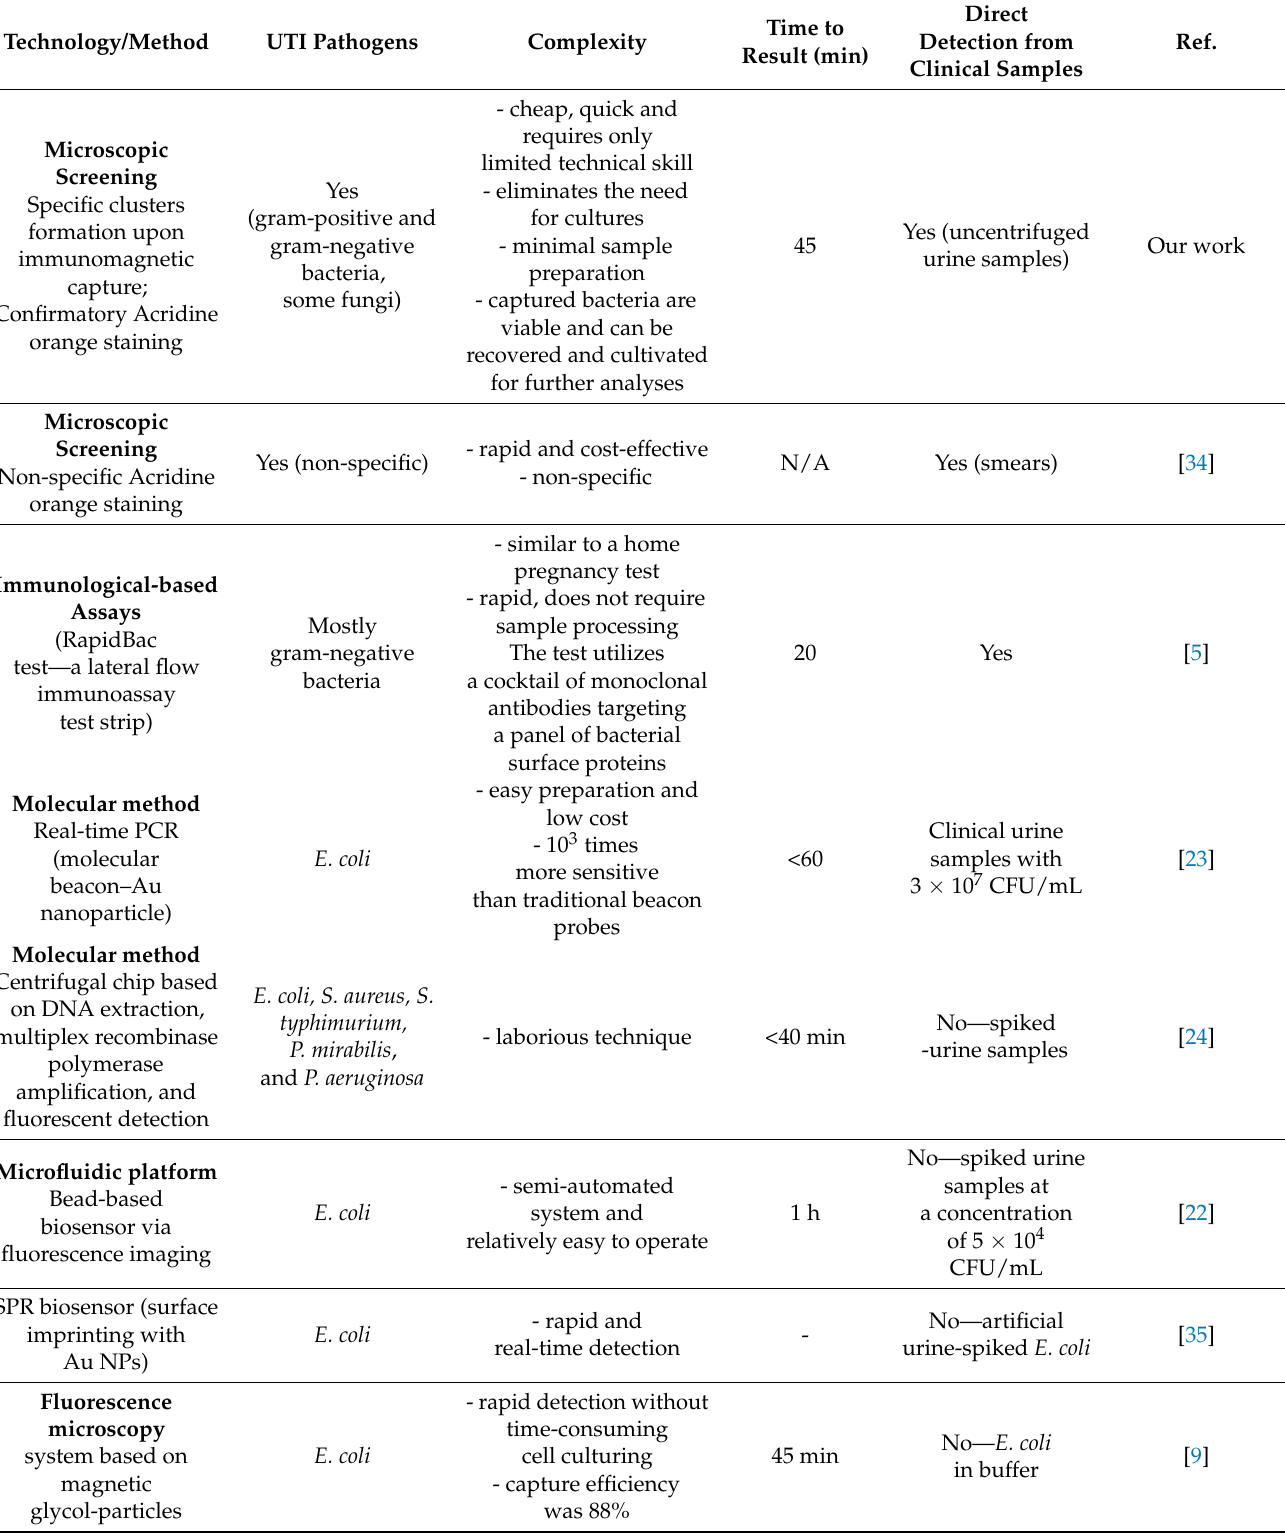
Table 4. Examples of different methods (marked with bold font) for E. coli and other bacteria